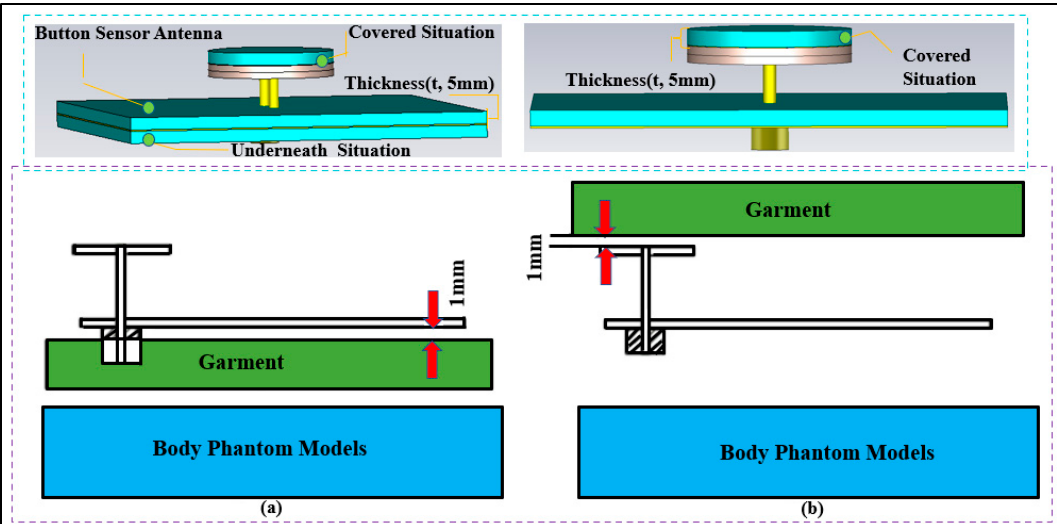
Figure 13. Button sensor antenna with the fabric placed ( a ) under the antenna, and ( b ) over the antenna (fabric thickness t: 5 mm).